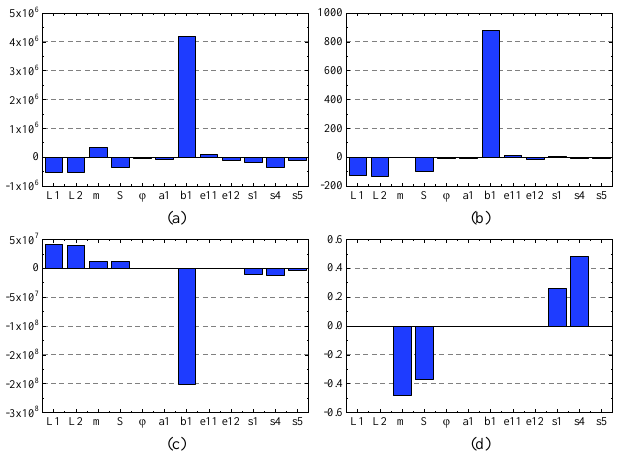
Figure 12. Design sensitivity for objective function: ( a ) the overall objective function; ( b ) flow rate; ( c ) maximum pressure; ( d ) stability margin.